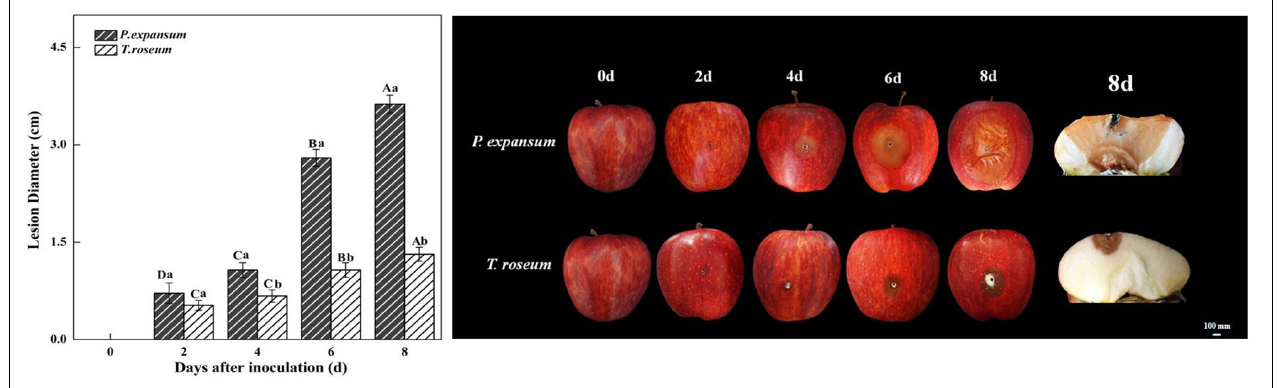
FIGURE 1 | Effects of Penicillium expansum and Trichothecim roseum inoculation on lesion diameter of apple fruit during storage. All data are expressed as means ± standard deviation of triplicate samples. Different letters indicate significant differences ( P < 0.05). The picture on the right shows the lesion diameter of fruit inoculated with the two pathogens during storage.